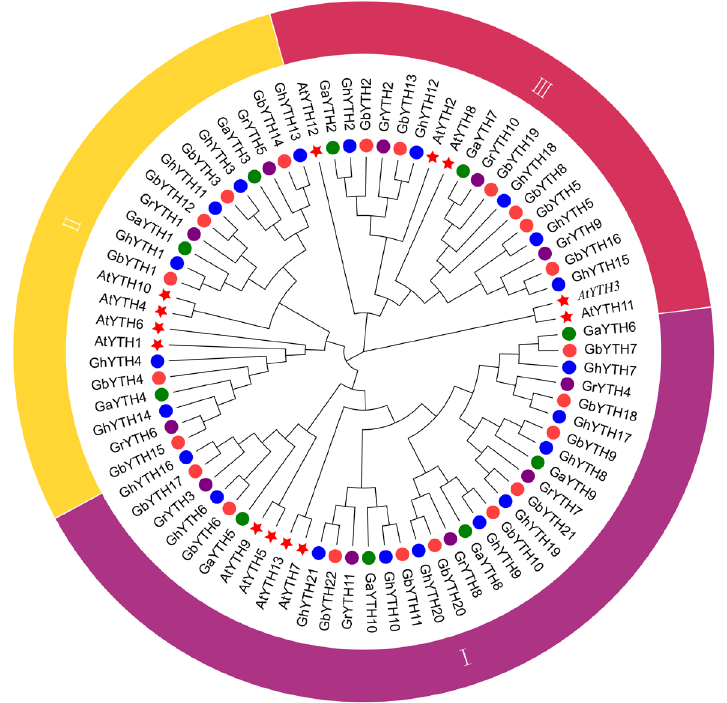
Figure 1. Phylogenetic analysis of YTH gene family in Gossypium and Arabidopsis . The phylogenetic tree resolved YTH genes into three groups. The phylogenetic ML tree was constructed using the amino acid sequence with a 1000 bootstrap value with MEGA-X software (version 7.0). YTH genes were categorized into threegroups from Group I to Group III. Ga, Gossypium arboretum ; Gr, Gossypium raimondii ; Gh, Gossypium hirsutum ; Gb, Gossypium barbadense ; At, Arabidopsis thaliana .